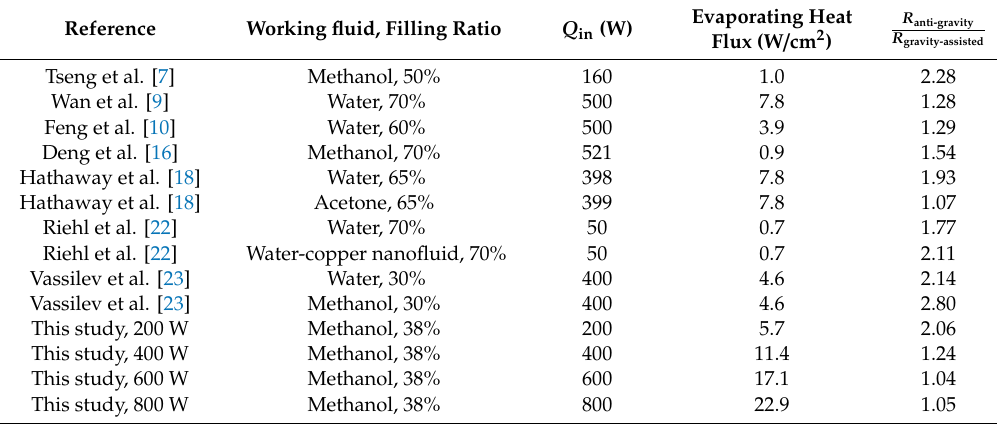
Figure 13. Thermal Resistance Ratio of anti-gravity condition to gravity-assisted condition vs. evaporating heat flux. Table 3. Reference for comparison with this study and main parameters.